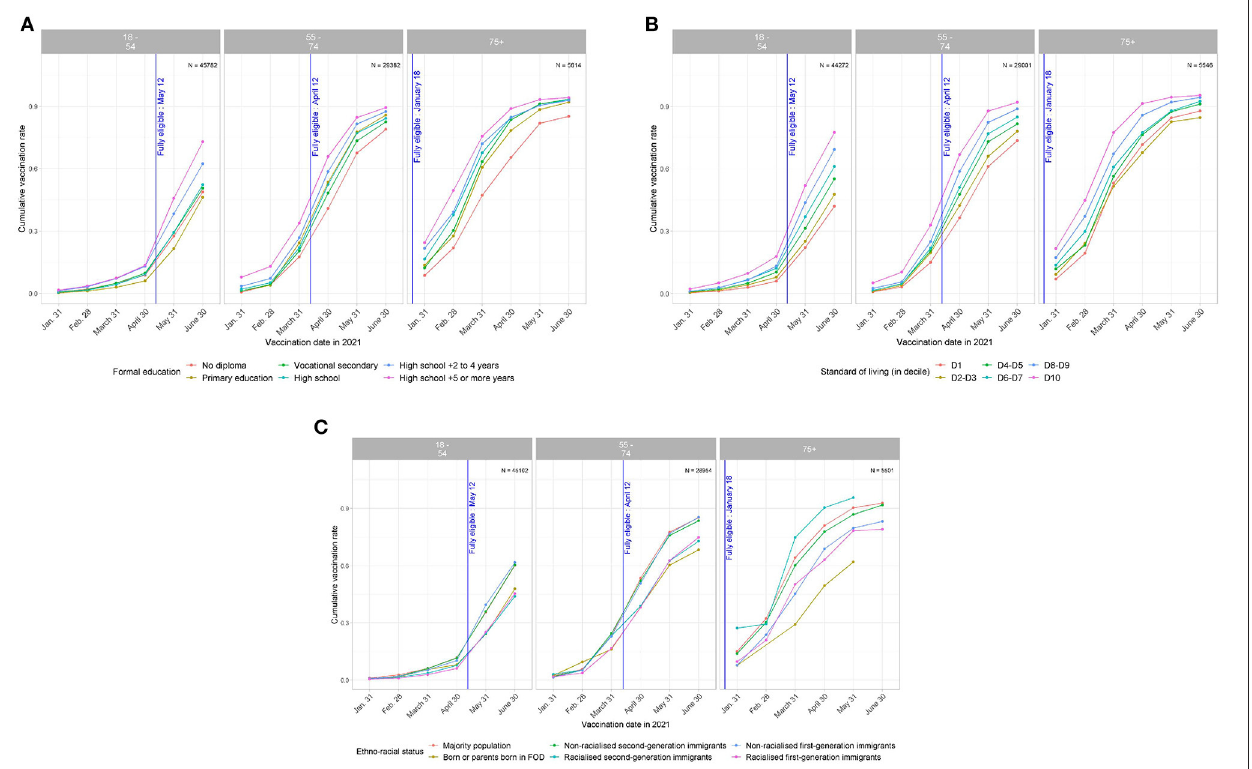
FIGURE 1 | (A) Trends over time in vaccination cumulative incidence rates by age, according to level of education. EpiCov study, 3rd wave, July 2021. (B) Trends over time in vaccination cumulative incidence rates by age, according to standard of living (in decile). EpiCov study, 3rd wave, July 2021. (C) Trends over time in vaccination cumulative incidence rates by age, according to ethno-racial status. EpiCov study, 3rd wave, July 2021.